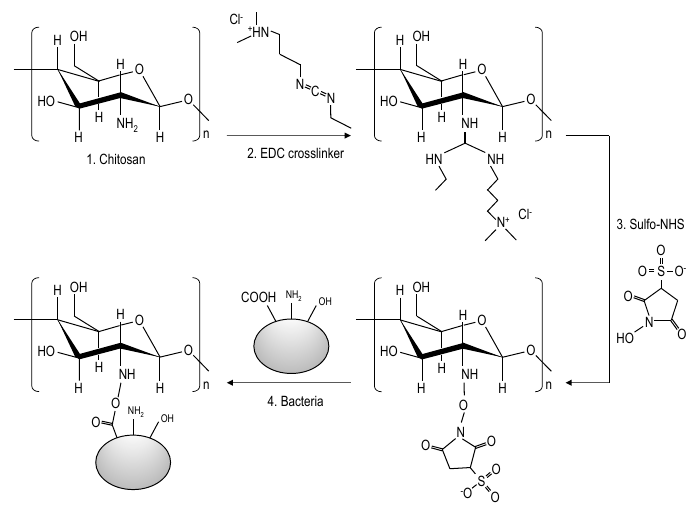
Figure 3. Reaction of the carbodiimide compound (EDC) with chitosan free amines (1, 2). The intermediate is stabilized by the formation of sulfo-NHS (3) which undergoes nucleophilic substitution to form an amide bond with the carboxyl groups on the bacteria (4).